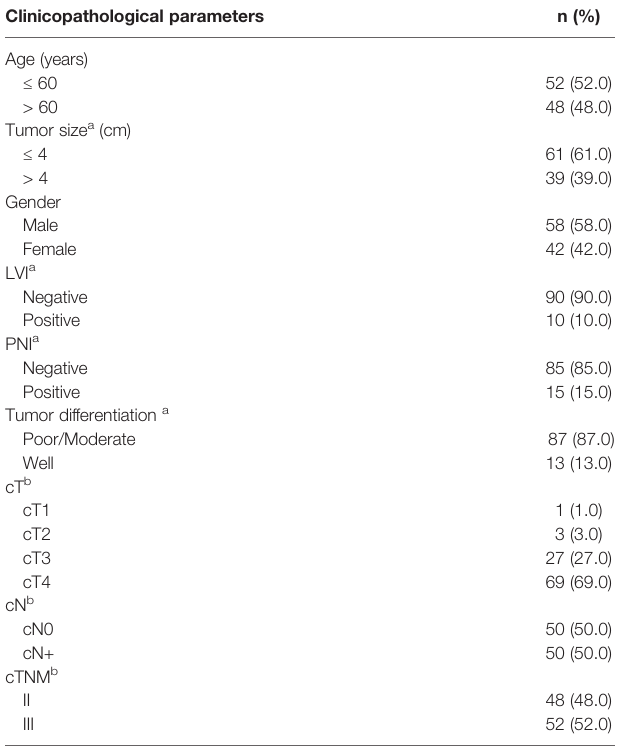
TABLE 2 | Clinicopathological parameters of pMMR CRC patients (n = 100). Clinicopathological parameters